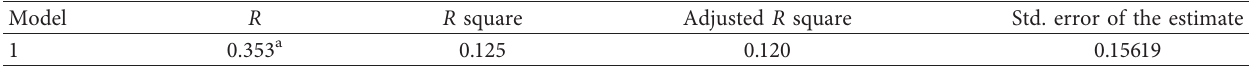
Table 7: Model Summary regarding impact of BIM on Scheduling (model summary).